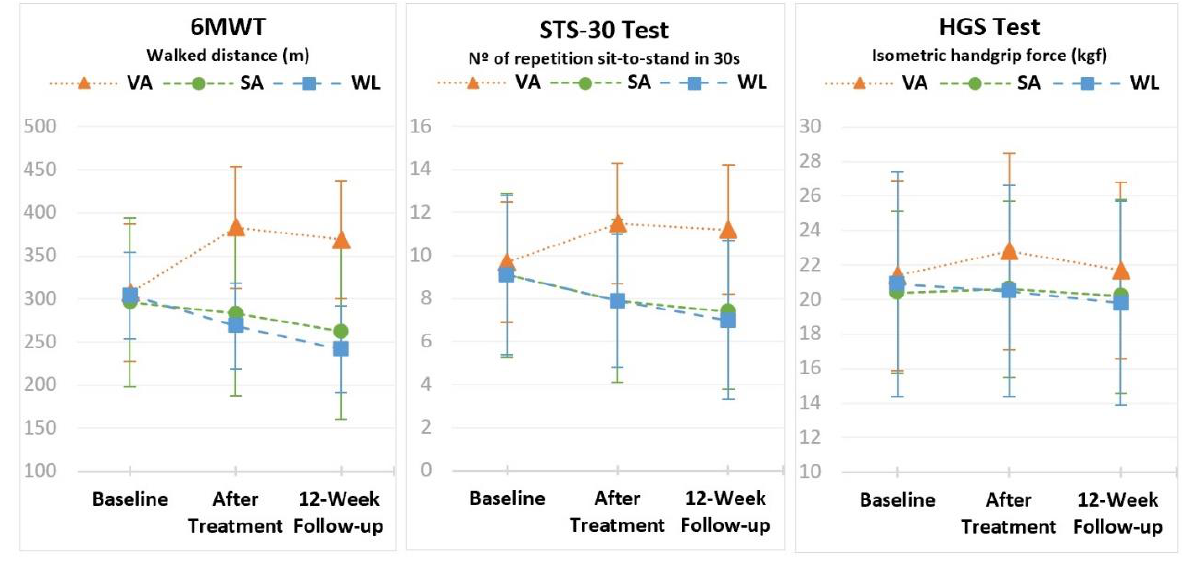
Figure 2. Means ( ± SD) of 6MWT, STS-30 Test and HGS Test in the baseline assessment, after treatment and follow-up assessment, within each group (VA—Verum Acupuncture Group, SA— Figure 2. Means (±SD) of 6MWT, STS-30 Test and HGS Test in the baseline assessment, after treat- Sham Acupuncture Group, WL—Waiting-List Group). ment and follow-up assessment, within each group (VA — Verum Acupuncture Group, SA — Sham Acupuncture Group, WL — Waiting-List Group). Table 4. Descriptive statistics and comparison of 6-Minute Walk Test (6MWT), 30-Second Sit-to- Stand (STS-30) Test and Handgrip Strength (HGS) Test by group and through time.